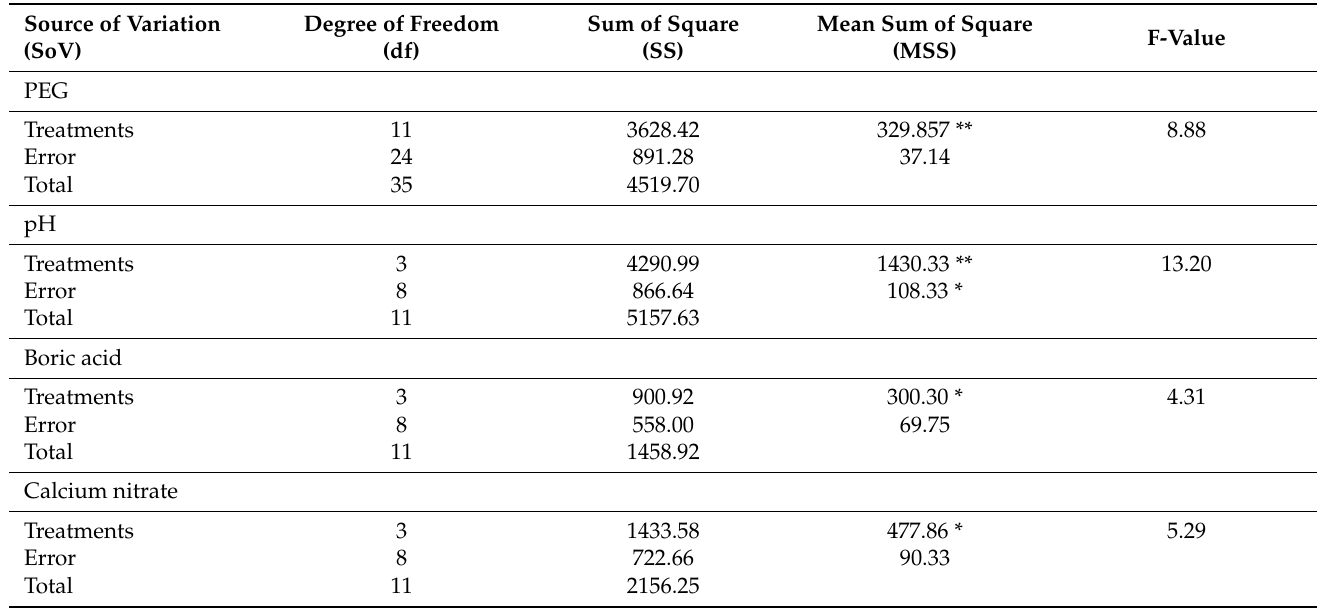
Table 3. ANOVA of pollen viability of the wheat genotype Gladius+Sr50 in different treatments of PEG, pH, boric acid and calcium nitrate.